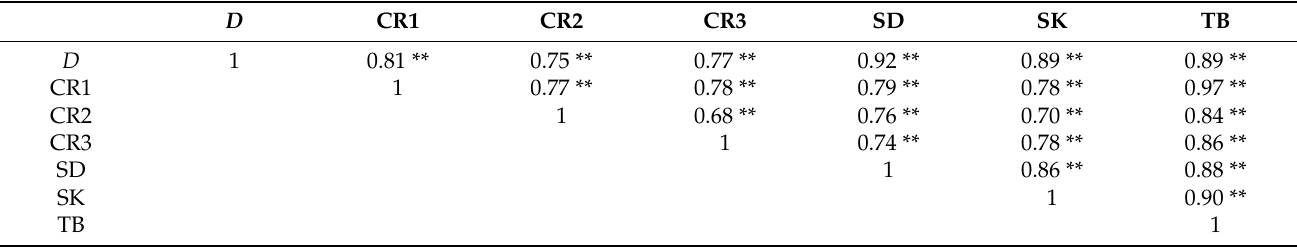
Table 6. Pairwise Pearson’s correlation coefficients (above diagonal) and their significance among variables of stumps and coarse root